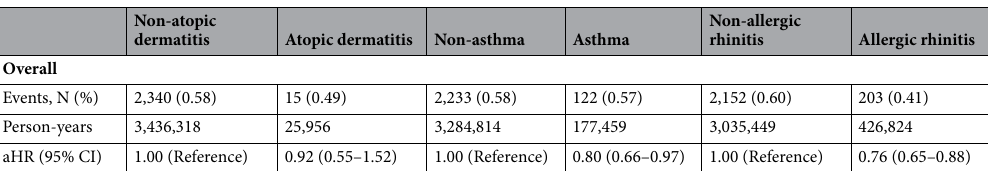
Table 3. Association of allergic diseases with risk of liver cancer. Hazard ratio calculated by Cox proportional hazards regression analysis after adjustments for age, sex, body mass index, Charlson comorbidity index, household income, smoking, alcohol consumption, physical activity, systolic blood pressure, fasting serum glucose, total cholesterol, history of hepatitis B virus/hepatitis C virus infection and liver cirrhosis and the number of outpatient visits.